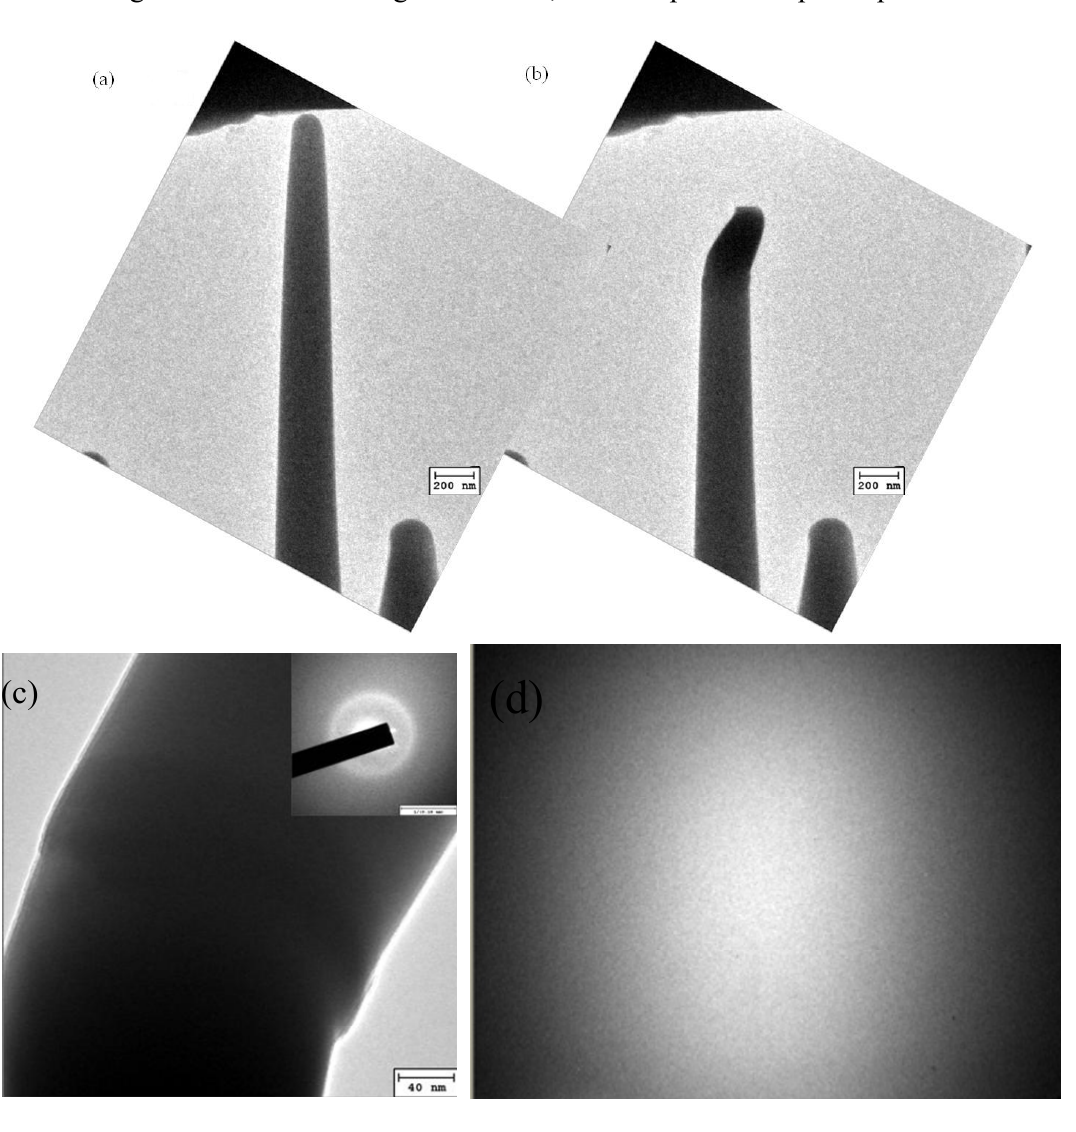
Figure 8. TEM bright field images of a Zr-based metallic glass nano-pillar ( a ) before, and ( b ) after the in situ TEM nano-compression experiment; ( c ) the buckling position of a Zr-based metallic glass nano-pillar; ( d ) the EBSD pattern of Zr-based metallic glass after high strain rate